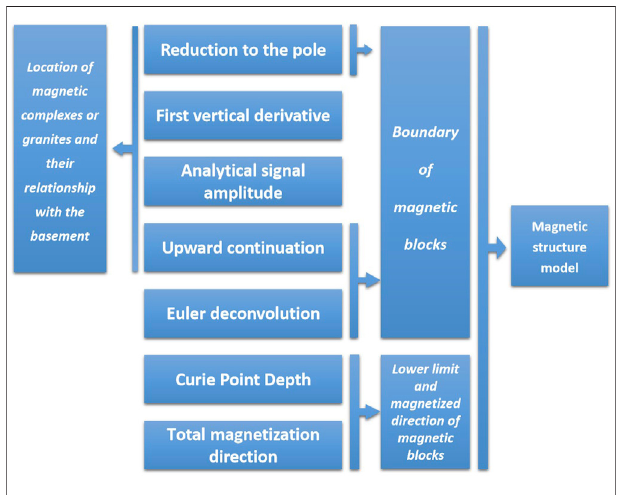
FIGURE 2 | Flow chart for the magnetic anomaly